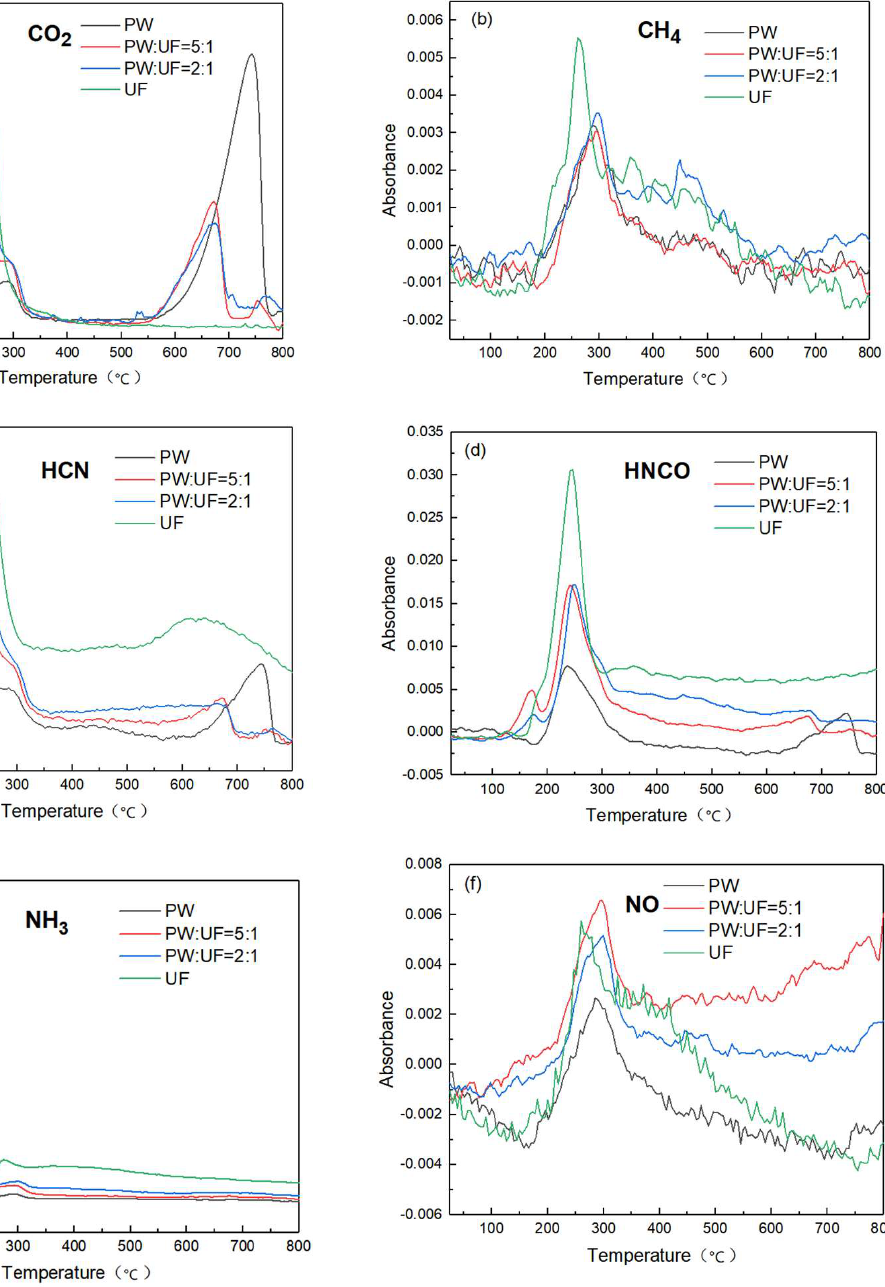
2 is mainly produced by decarboxylation and decarbonylation